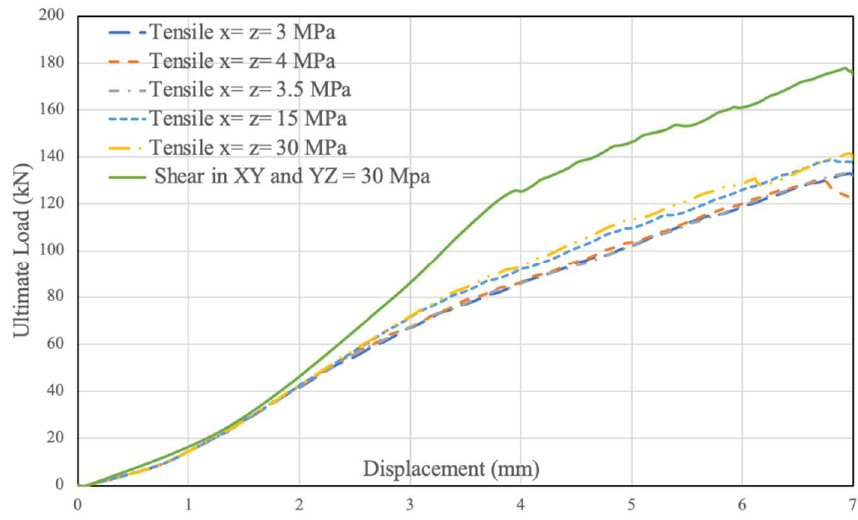
Figure 21. Impact of Tensile and Shear Strength on Ultimate Load.